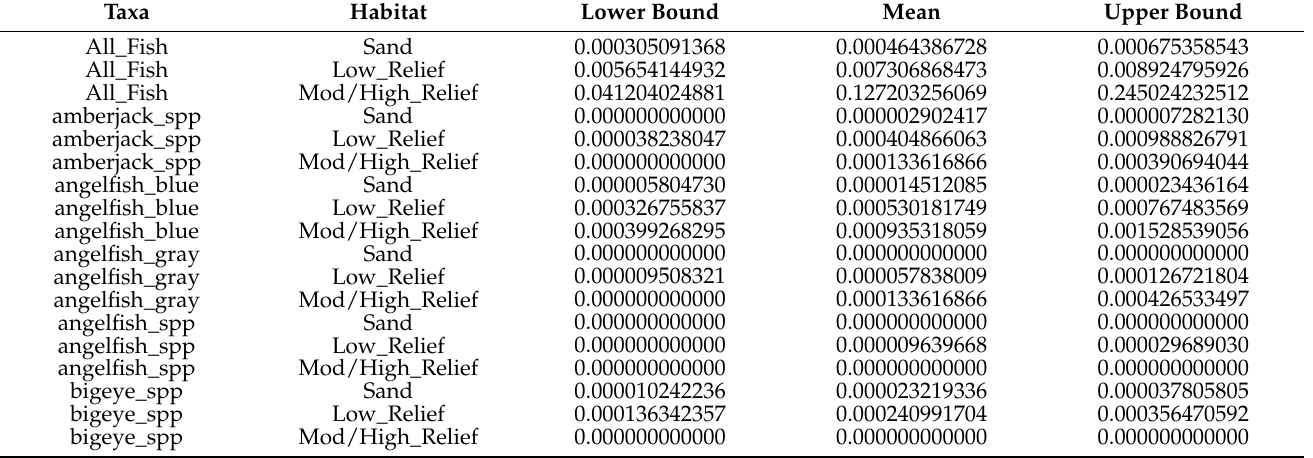
Taxa Habitat Lower Bound Mean Upper Bound All_Fish